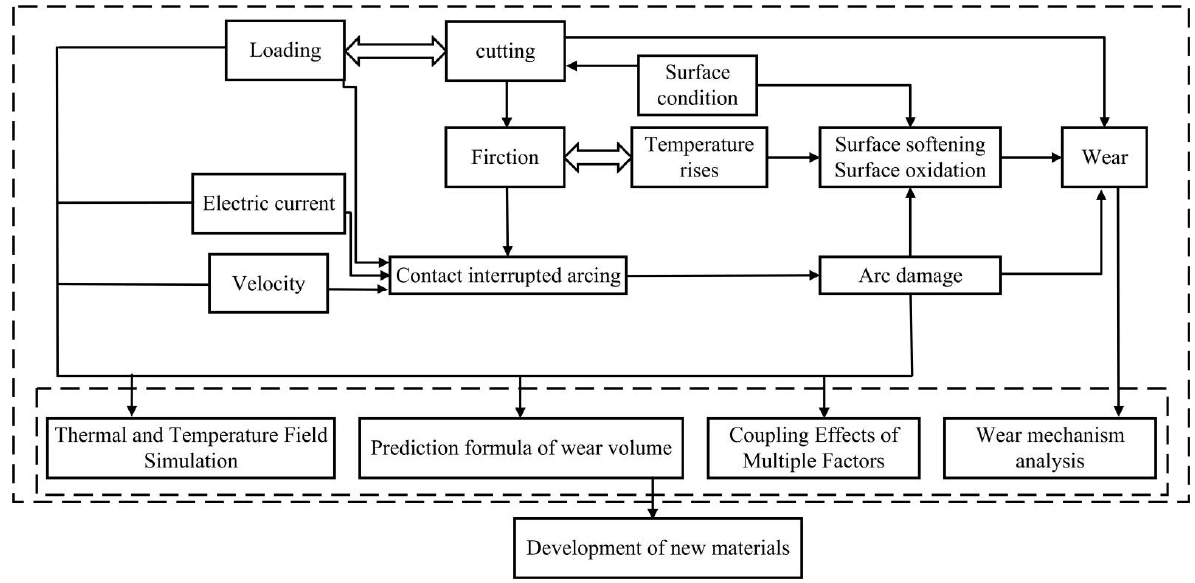
Figure 4. The current-carrying friction and wear research field.